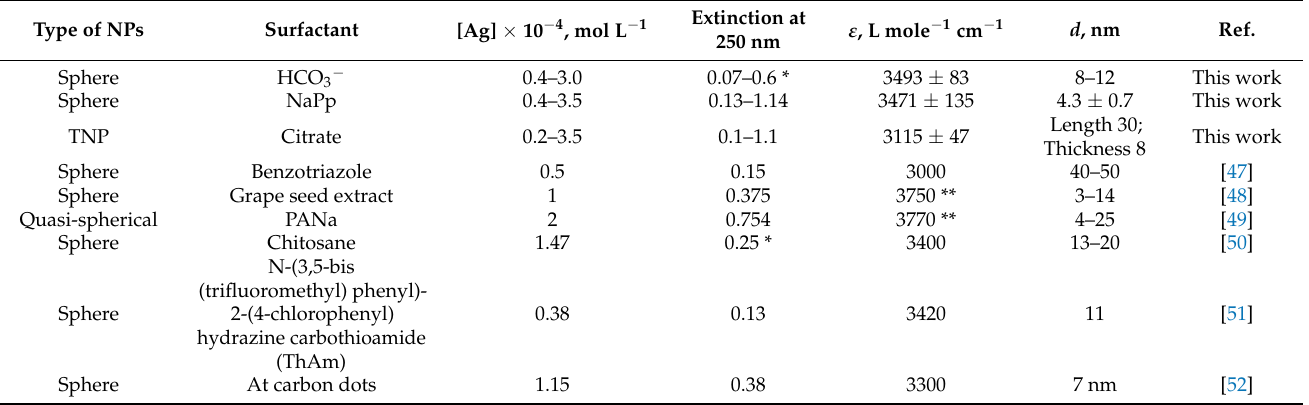
Table 3. Comparison of the extinction coefficients ( ε ) obtained in this work and those calculated from the data of other works.